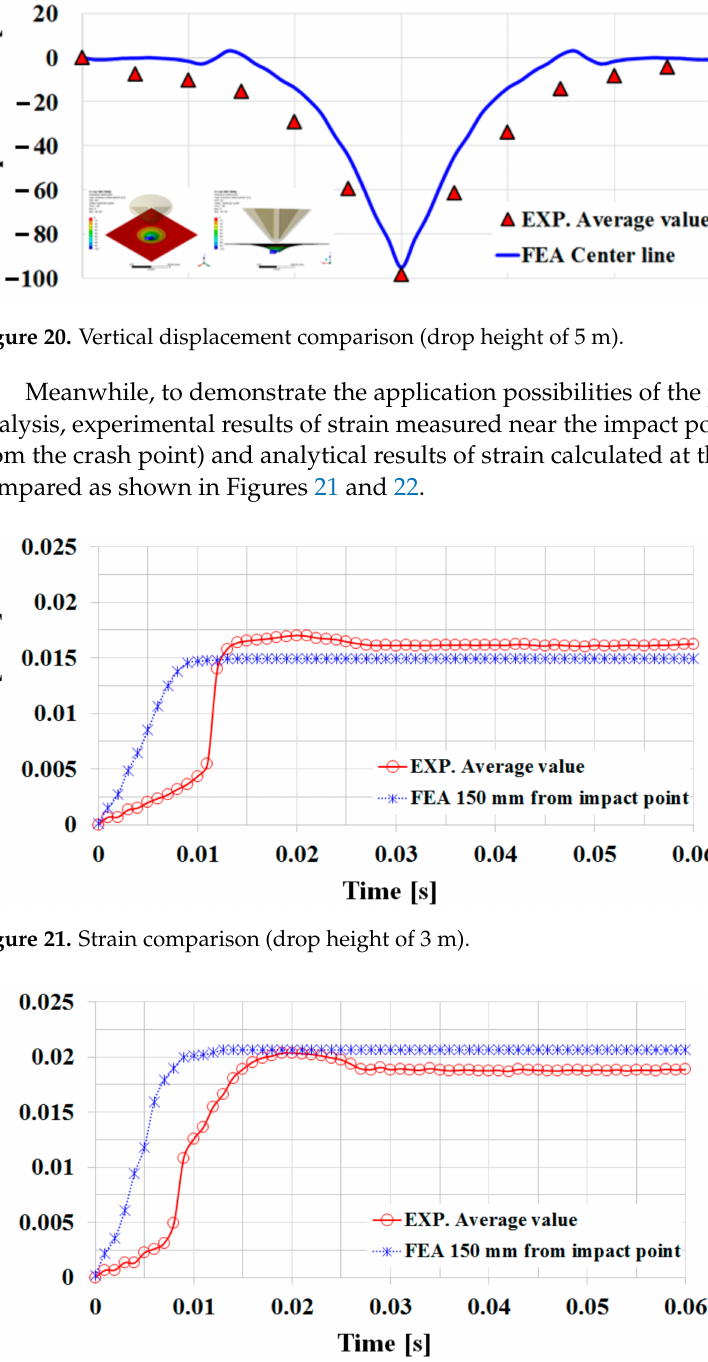
Figure 22. Strain comparison (drop height of 5